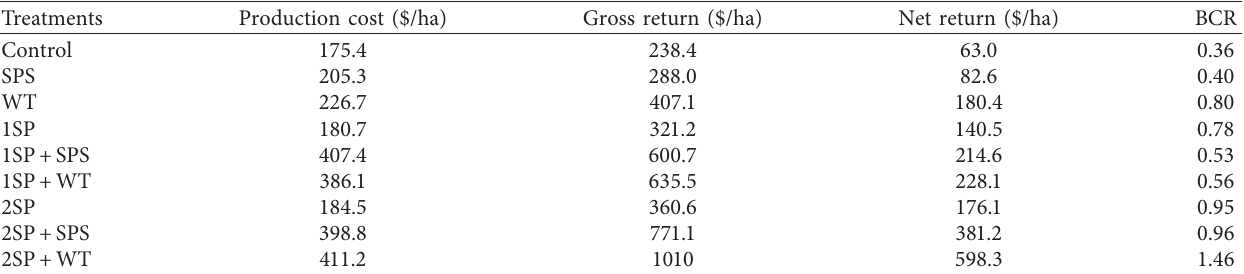
Table 2: Cost of production, gross return, net return, and benefit/cost ratio of tomato as affected by pruning and staking.